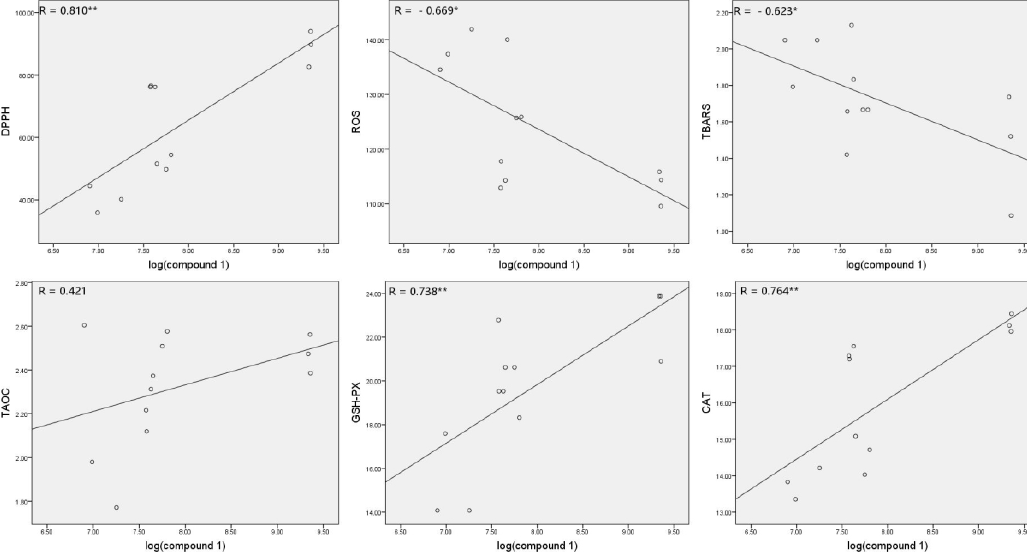
Figure 6. Correlations between the content of compound 1 (ion intensity at logarithmic scale) and antioxidant parameters (* p < 0.05; ** p < 0.01).